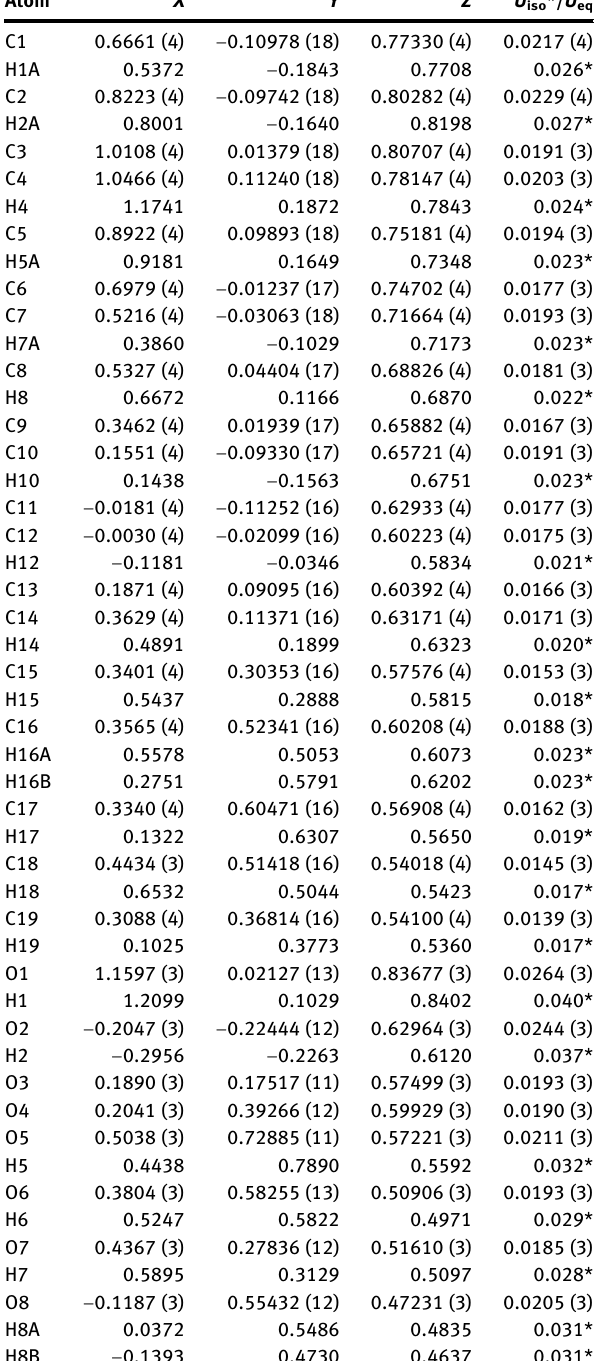
Table  : Fractional atomic coordinates and isotropic or equivalent isotropic displacement parameters (Å 